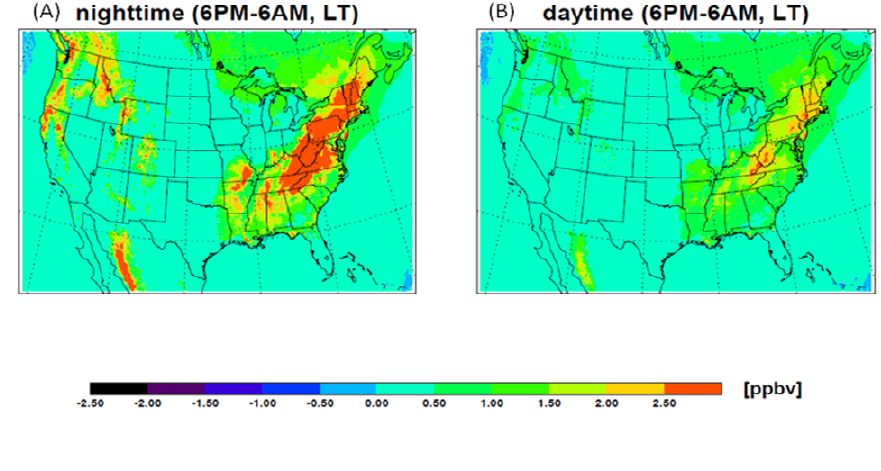
Figure 2. Difference plot for monthly average surface ozone for August 2009 predicted by WRF-NMM/CMAQ for the case z obtained from the MET model minus that with satellite 0 observation of canopy height—opposite of the subtraction for Figure 1C and D, to show the effect of reduced aerodynamic resistance by applying the satellite observed canopy height, for ( A ) nighttime hours between 6:00 pm and next day 6:00 am local; and ( B ) daytime hours between 6:00 am and 6:00